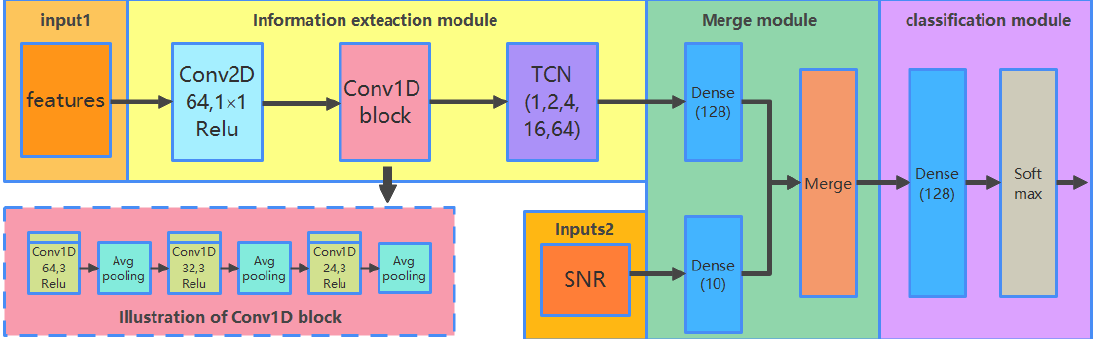
Figure 4. Structure of the proposed CCT modulation classifier.